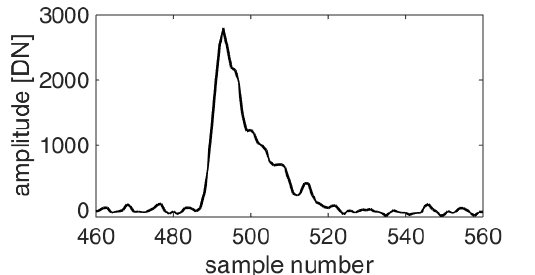
Figure 5: Example of a digitized waveform with poor bottom point echo re cognizability (Richter et al., 2017)